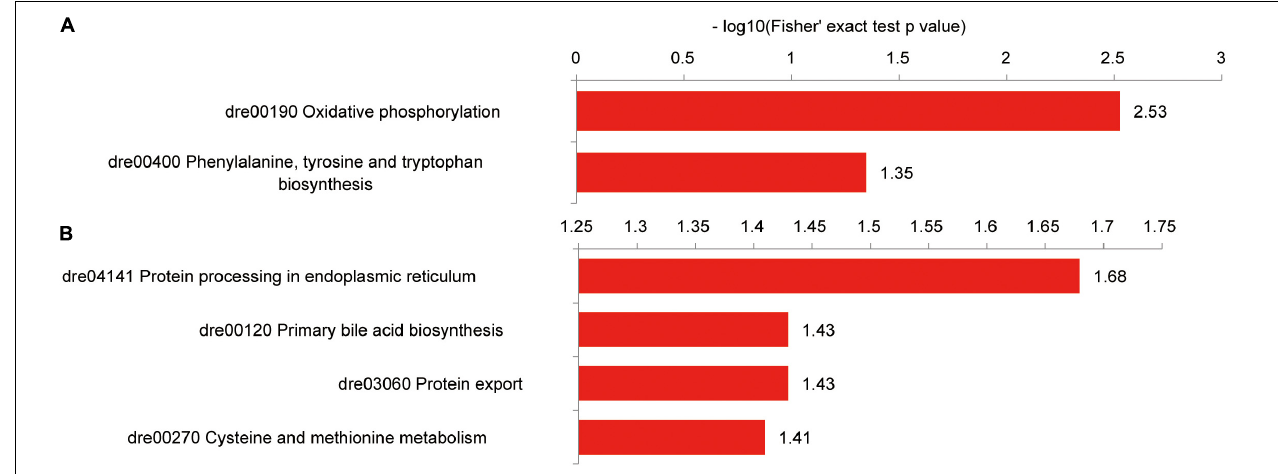
FIGURE 10 | KEGG pathways of differentially succinylated proteins in the liver of zebrafish fed the CK or S0.15 diet for 4 weeks. (A) Pathways involved in proteins with increased succinylation. (B) Pathways involved in proteins with decreased succinylation.